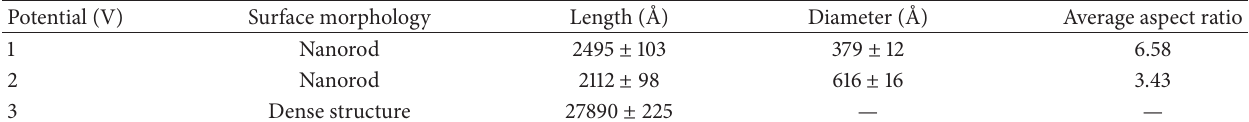
Table 3: Average values for length, diameter, and aspect ratio for different applied potentials.